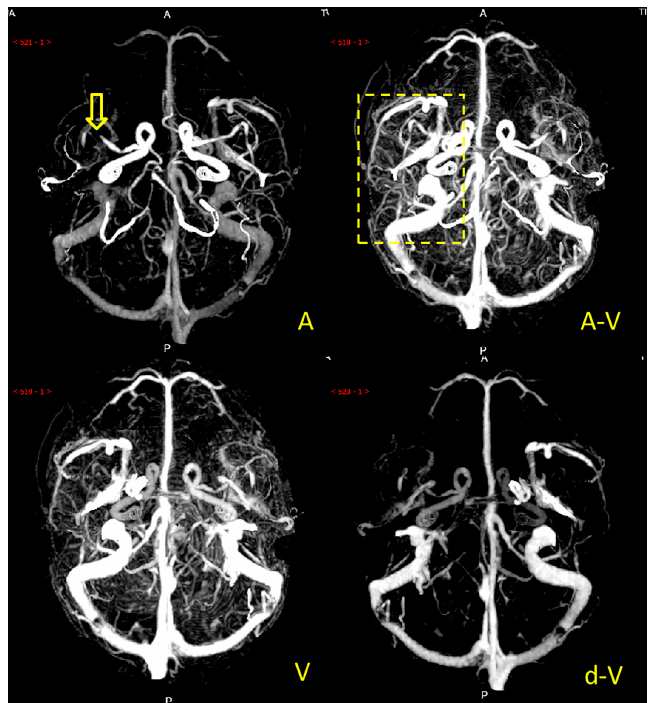
Figure 3. Example of a patient with good collateral circulation. Note: the M1 segment of the right middle cerebral artery of the patient was occluded (the yellow arrow), and there were many collateral vessels in the blood supply area (the yellow dashed box) of the right middle cerebral artery in A (arterial phase), A-V (arteriovenous phase), V (venous phase), and d-V (venous late